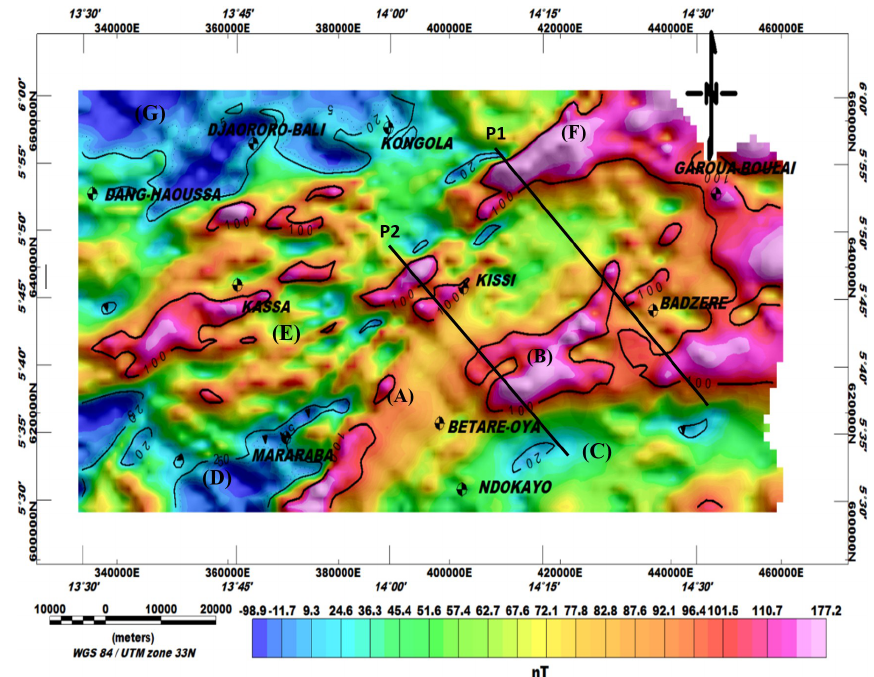
Figure 3. Total magnetic intensity (TMI) map reduced to the Equator.